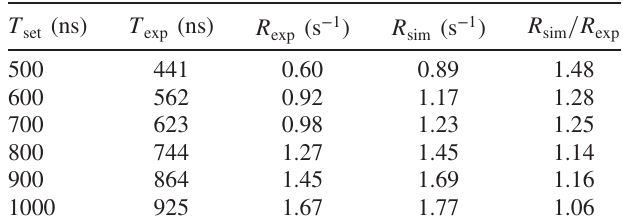
TABLE V. Comparison between simulated and measured bunch length reduction rates. T and measured electron bunch lengths, respectively. R longitudinal bunch length reduction rate as shown in Fig. 16; R is the corresponding simulation